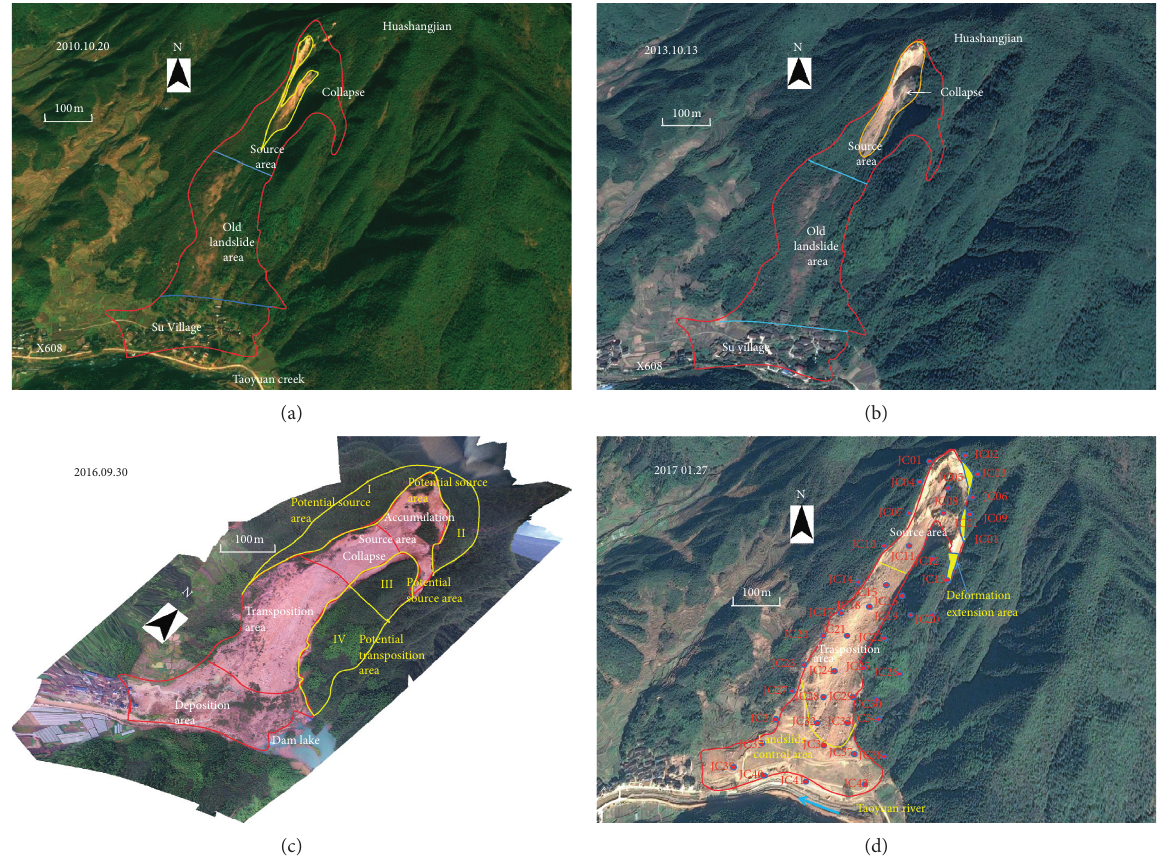
Figure 4: Photographs of the Sucun landslide. (a) Image was taken on October 20, 2010 (from Google Earth). (b) Image was taken on October 13, 2013 (from Google Earth). (c) Aerial photograph was taken on September 30, 2016, and subdivided landslide. (d) Image was taken on January 27, 2017, and distribution of monitoring points (from Google